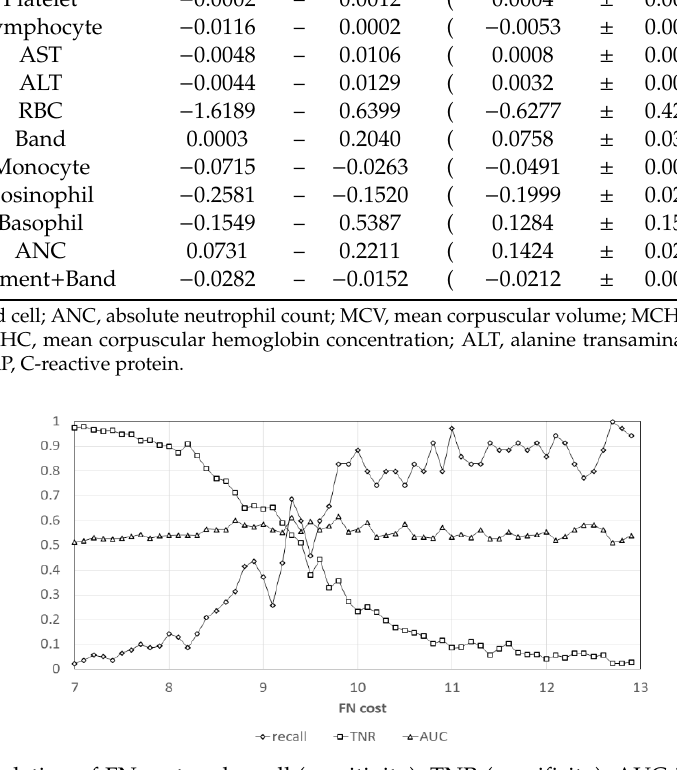
Figure 2. The relation of FN cost and recall (sensitivity), TNR (specificity), AUC in our predictive model. FN, false negative; TNR, true negative rate; AUC, area under ROC curve.